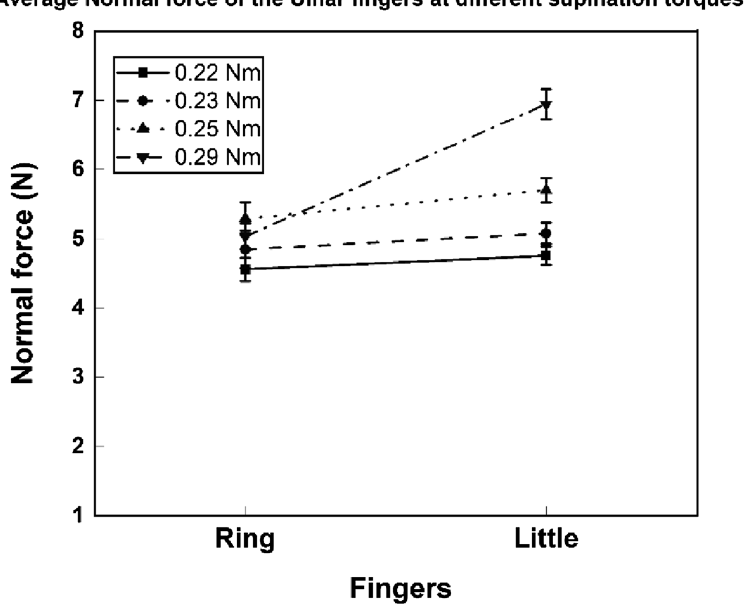
Figure 5. Normal forces of ring and little fingers for supination efforts under different loading conditions/ supination torque requirement. For 0.29 Nm torque requirement (represented by dashes with dots), the normal force of little finger was found to be statistically greater than ring finger normal force. In all the other conditions, ring and little fingers produced comparable normal force. The bars indicate standard errors of